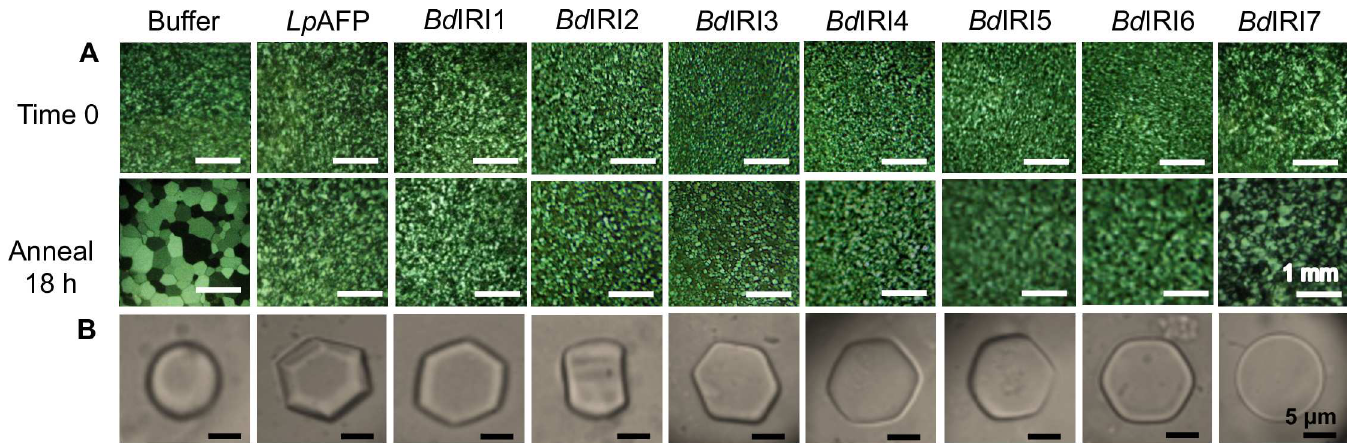
Fig 8. Ice-binding activity of Bd IRI proteins produced in E . coli . Ice recrystallization inhibitionactivity was observedfor all 7 Bd IRI recombinantproteins as indicated, as well as purifiedrecombinant Lp AFP and buffer controls (see text). Images were capturedimmediately (time 0) and followingan annealing period of 18 h at − 4˚C (A). Ice crystal morphologies were also observed for all proteins(B). Assays were conductedusing 1 mg/mL of recombinant protein, in triplicate with representativephotos shown.